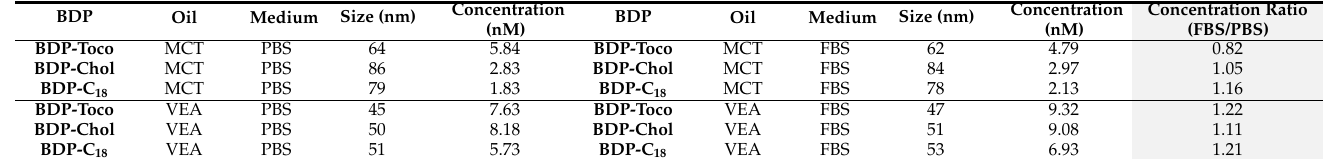
Table 3. Assessment of dye leakage from the 1 wt % dye-loaded NEs by Fluorescence Correlation Spectroscopy (FCS). BDP